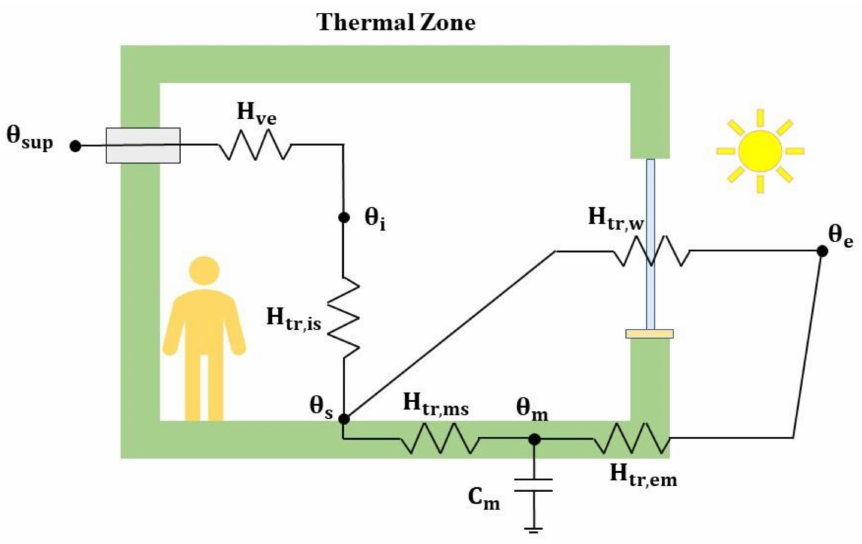
Figure 1. 5R1C thermal network scheme